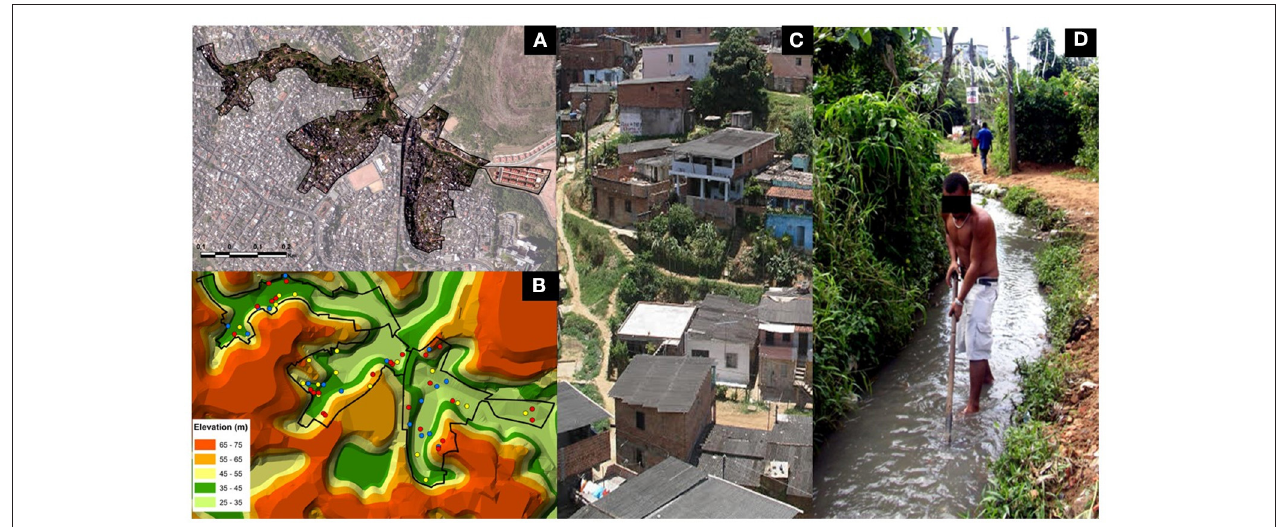
FIGURE 1 | Slum community site in the city of Salvador, Brazil. (A) Aerial photograph showing the study site boundary in the community of Pau da Lima, Brazil. (B) Topographic map highlighting the households participating in the subcohort study. In blue, households with uninfected individuals; in yellow, households with infected individuals and in red, households with reinfected individuals. Photographs showing social characteristics (C) and environmental risk factors (D) of the community.